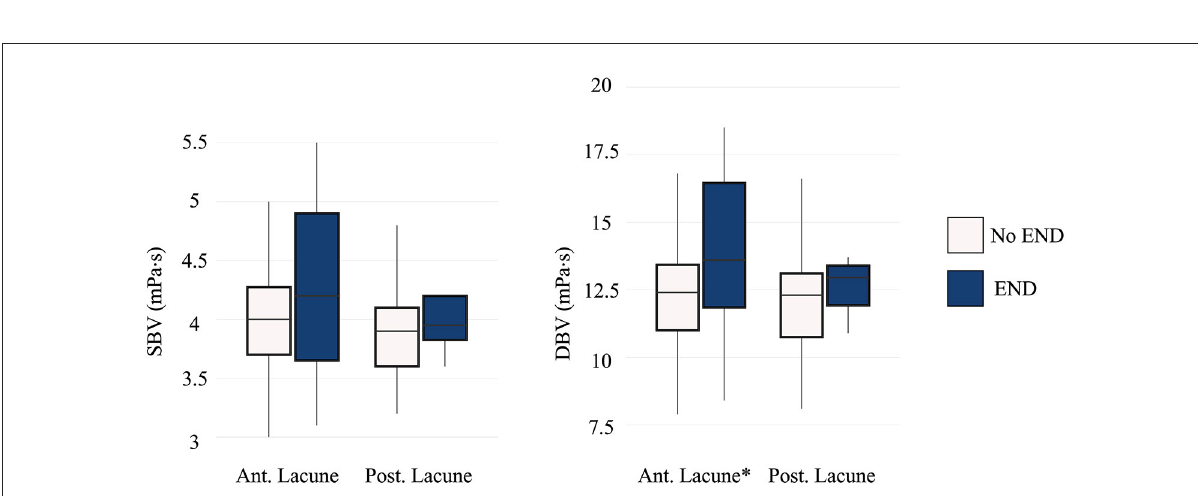
FIGURE3 Comparison of blood viscosity between the END and non-END groups according to location of ischemic lesion. END, early neurologic deterioration; SBV, systolic blood viscosity; DBV, diastolic blood viscosity; Ant. Lacune, anterior lacunar infarction; Post. Lacune, posterior lacunar infarction. Patients with lacunar infarction in anterior circulation showed significant difference in END ( P = 0.047). * p <